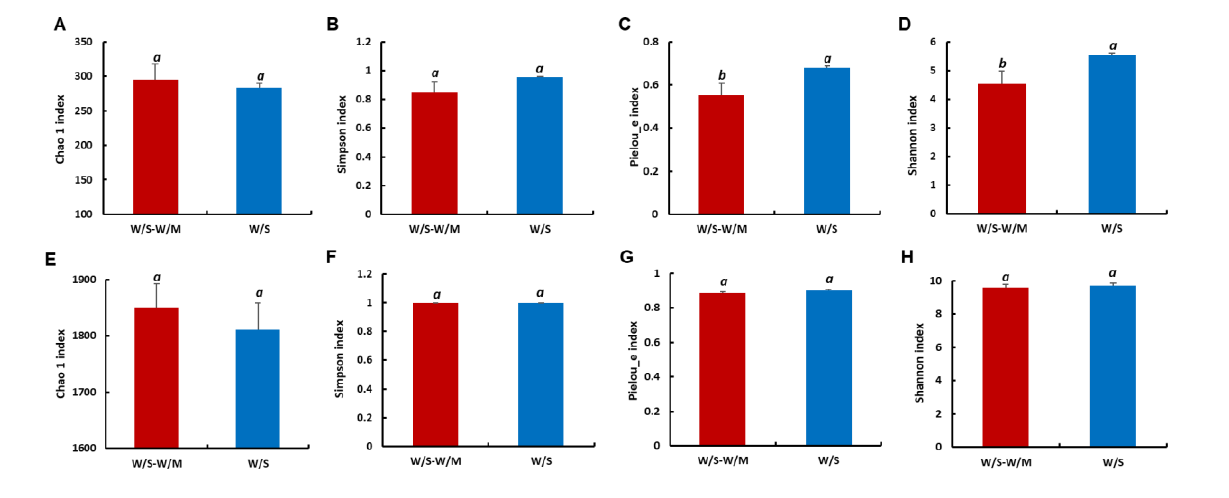
Figure 3. Richness (Chao 1 and Simpson) and diversity (Pielou_e and Shannon) of the fungal ( A – D ) and bacterial ( E – H ) communities in the rhizosphere soils. Different letters above columns signified statistically significant difference ( p < 0.05) according to Duncan’s test; the same letters are not significantly different between two cropping systems. W/S-W/M, wheat/soybean-wheat/maize rotation system; W/S, continuous wheat/soybean cropping system.